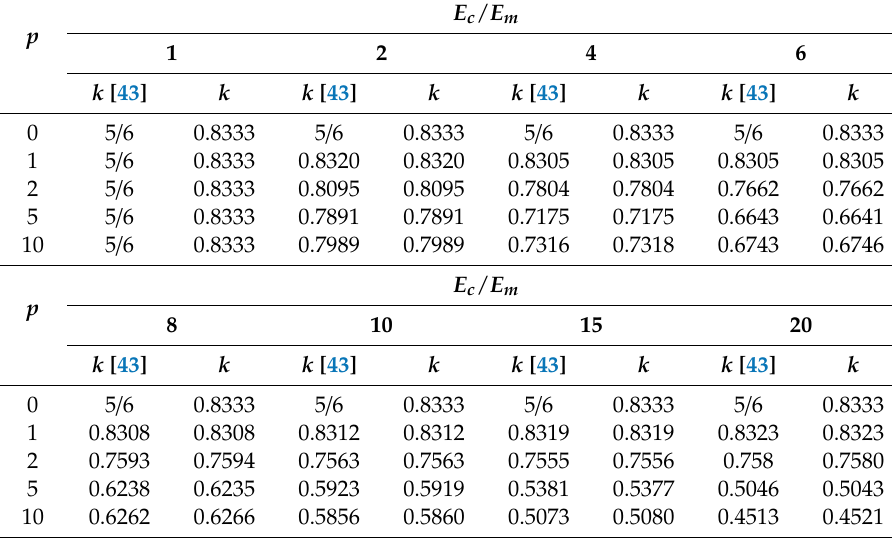
Table 1. Shear correction factor for di ff erent material